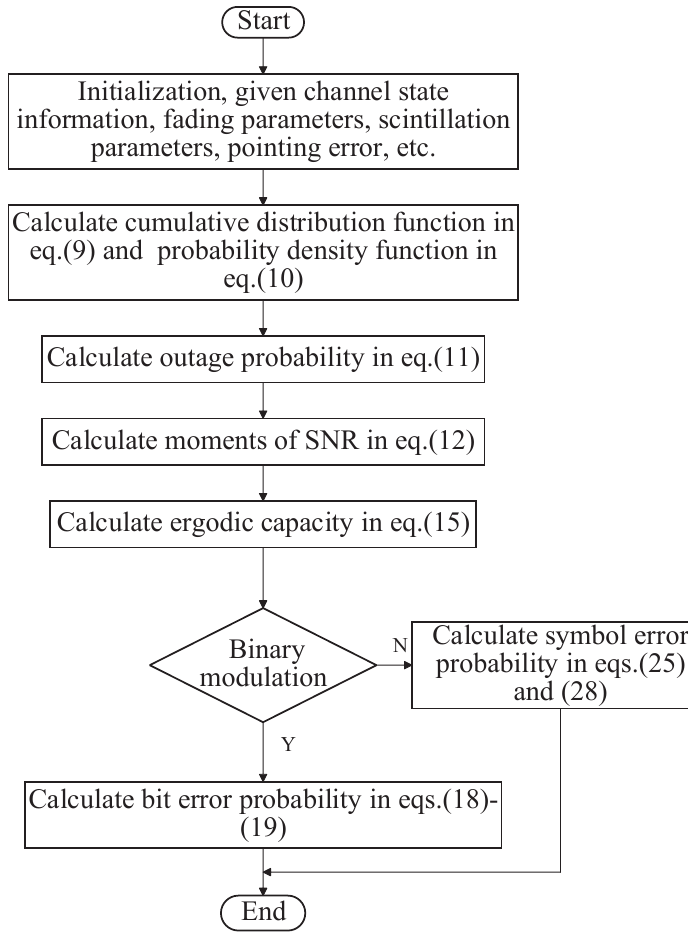
Figure 2. The flow chart of performance analysis